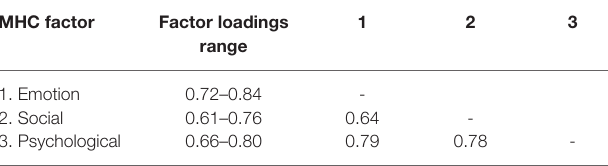
TABLE 5 | Results of the supported structural equation model for relationships between the 5 Cs of PYD and well-being factors from the Mental Health Continuum among the sample of university students in Ghana ( N =